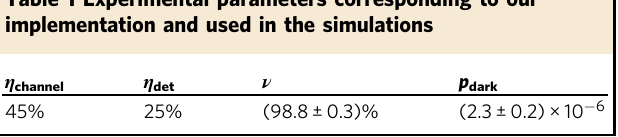
Best classical protocol Classical lower bound Coherent protocol (Ideal) Coherent protocol (Exp.) Coherent protocol (Exp. post process.) Exp. point measured Exp. point measured (Post process.) [bits]100